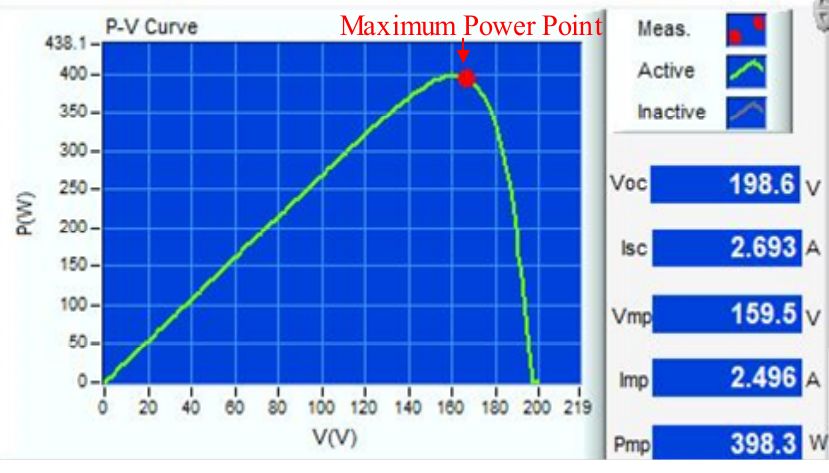
Figure 21. P-V characteristic curve of MPPT when the PVMA output power is at 400 W.